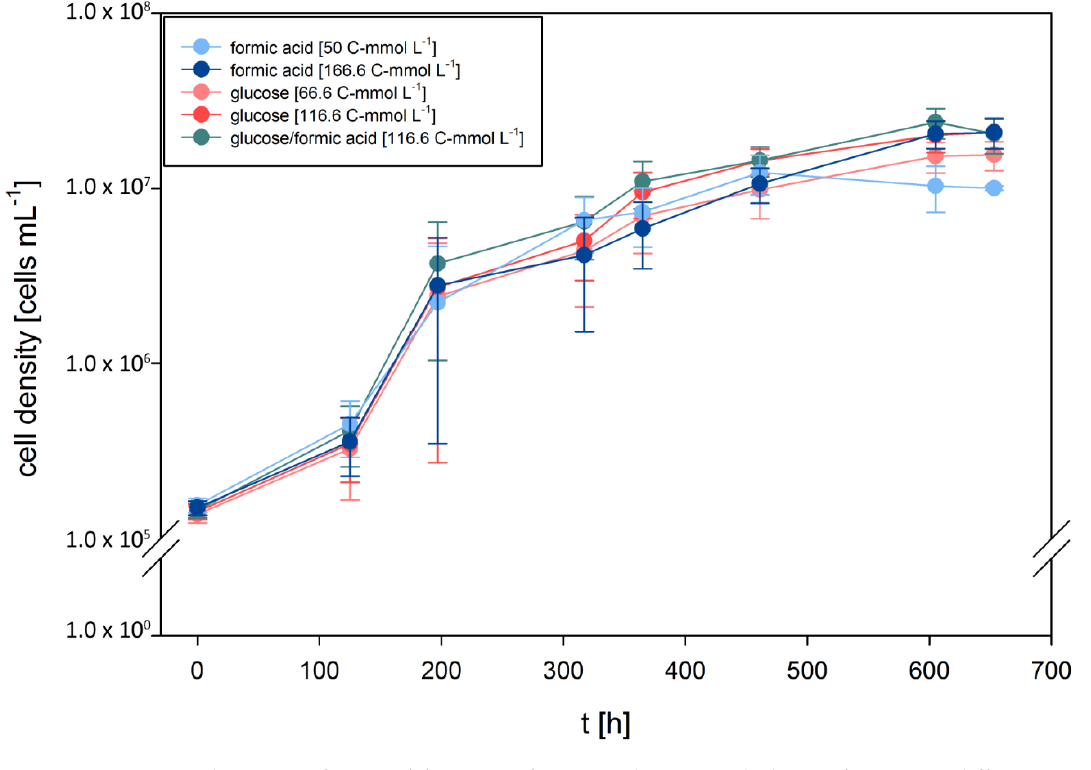
Figure 1. Growth curves of D. amylolyticus on formate, glucose, and glucose/formate at different concentrations. A slightly higher µ could be obtained when glucose/formate was used as substrate. All the substrate concentrations are given as C-mmol L −1 . A negative (un-inoculated) control and positive–negative (inoculated into medium where formic acid was omitted) control were performed in each set and no growth was observed. Table 1. Growth characteristics of D. amylolyticus.